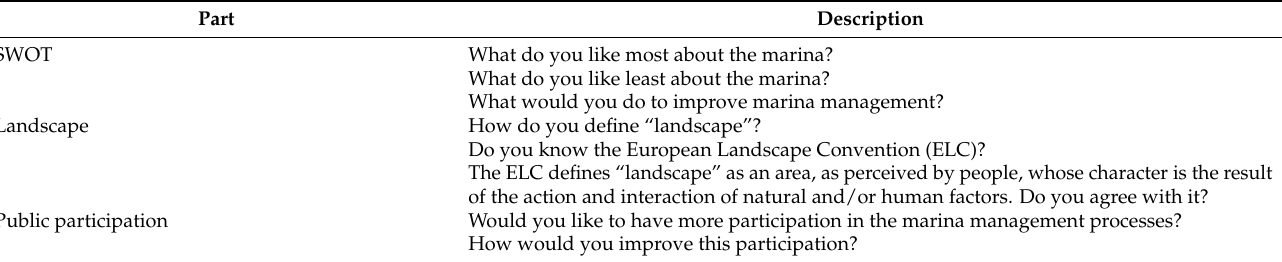
Table A1. Marina landscape values’